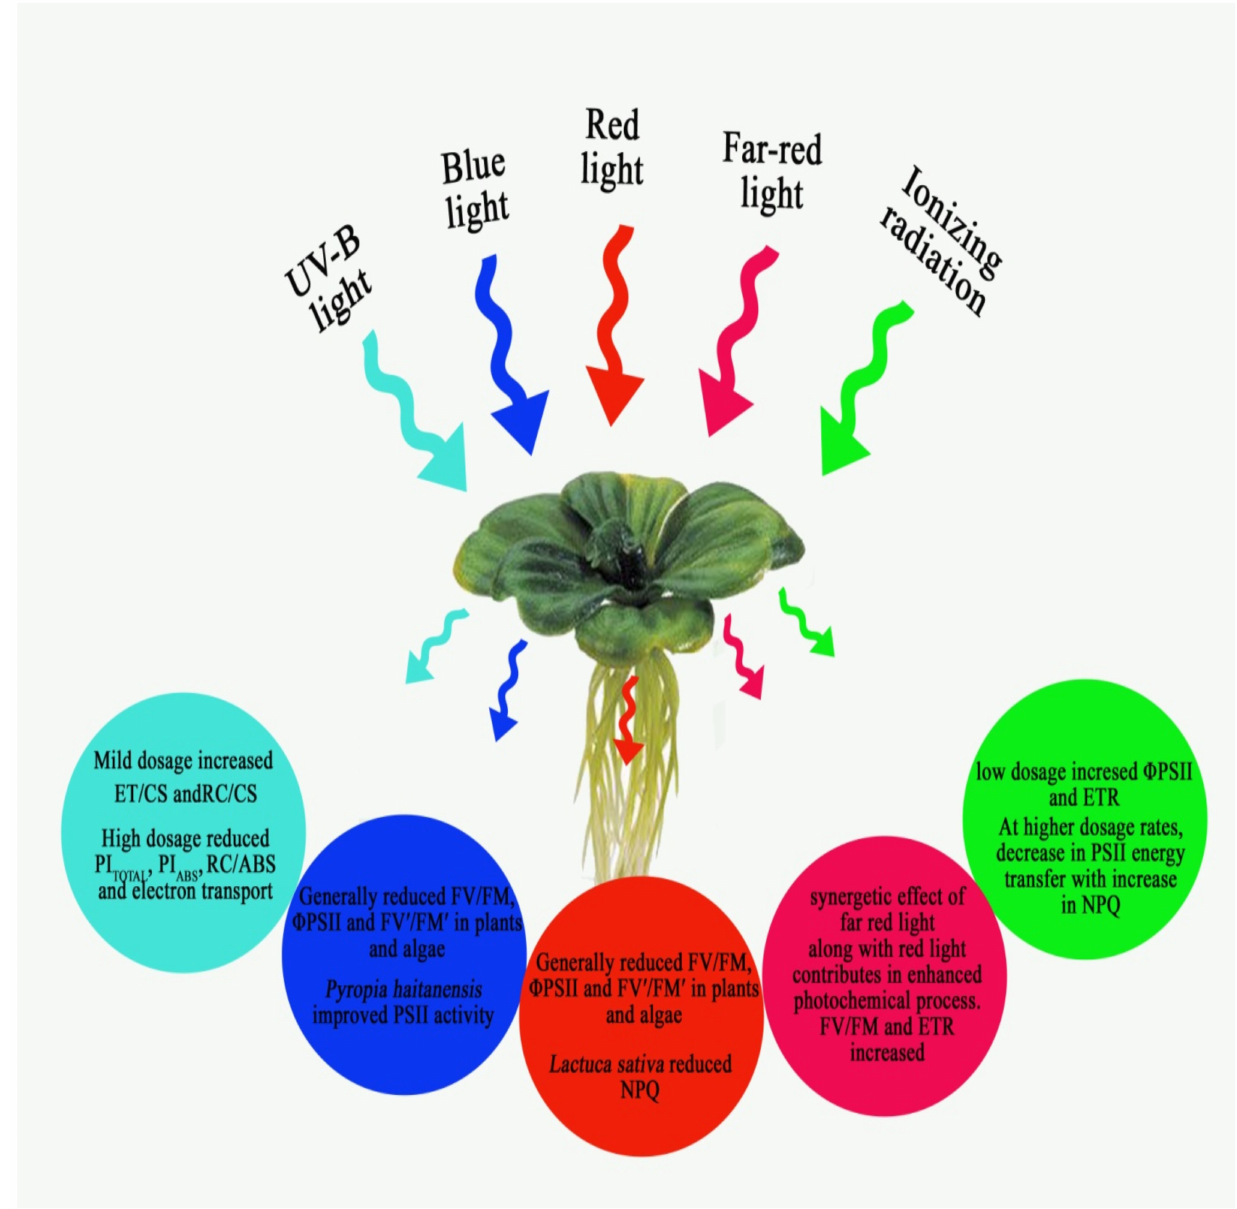
Figure 5. Impact of the spectral characteristics of light in the photosynthetic performance of